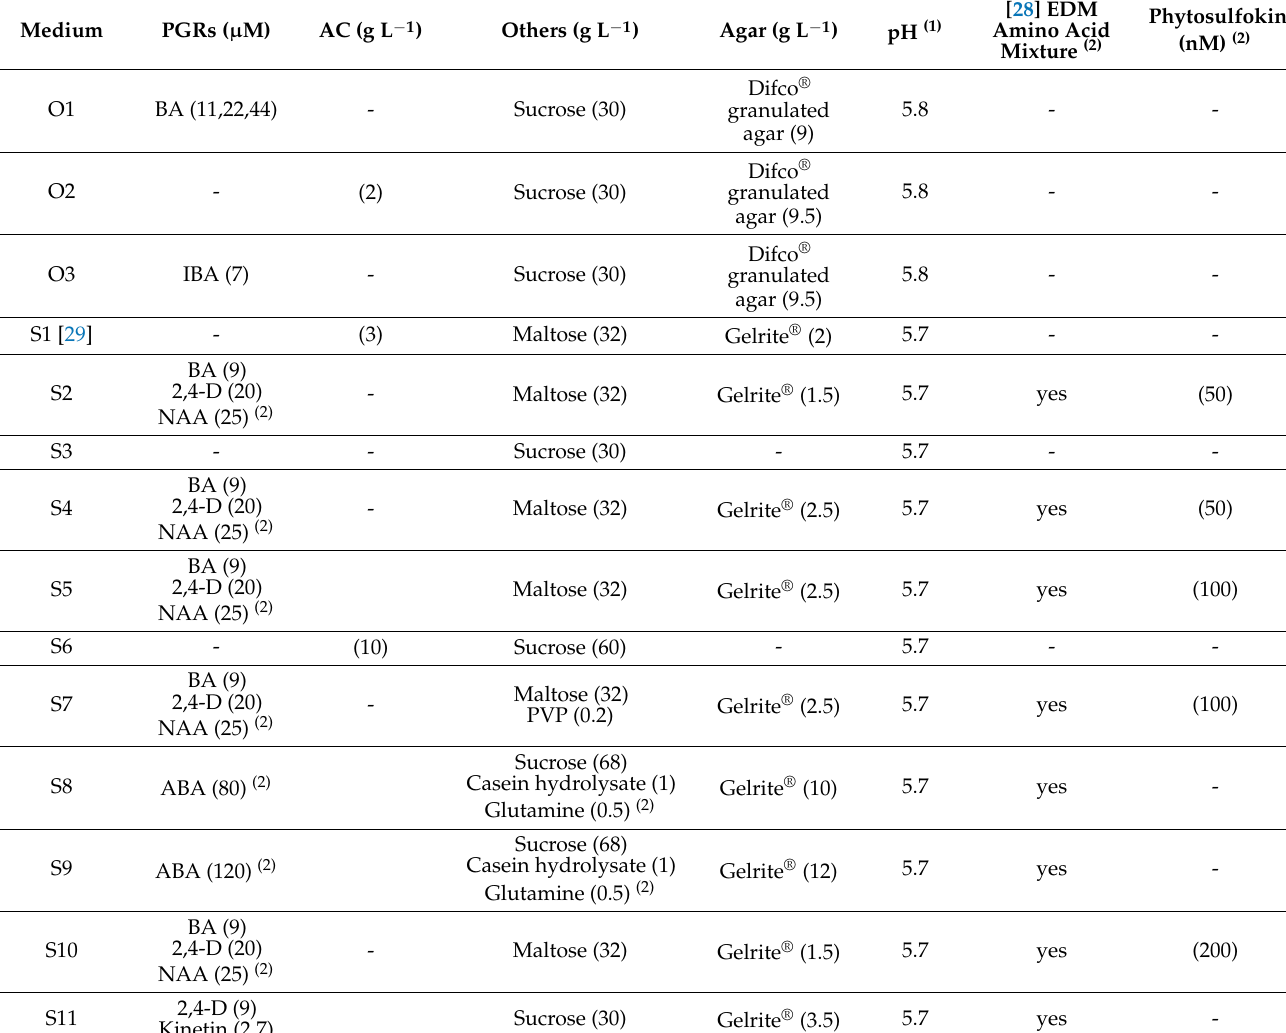
Table 1. Variations of basal DCR medium [27] used along different stages of P. halepensis organogenesis (O1–O3) and embryogenic tissue induction